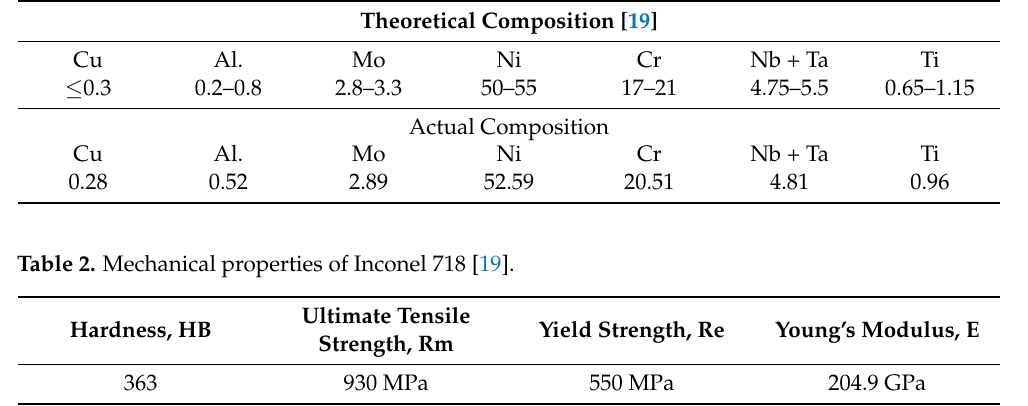
KIN I: the workpiece being stationary and the tool performing both the primary (rotary) and secondary (linear) motions